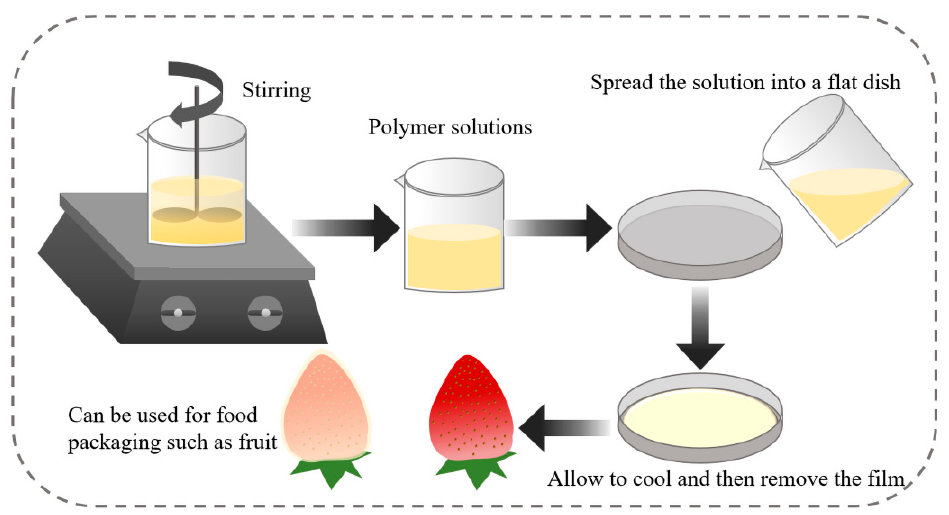
Figure 1. Schematic diagram of the preparation of packaging materials by the flow casting method.